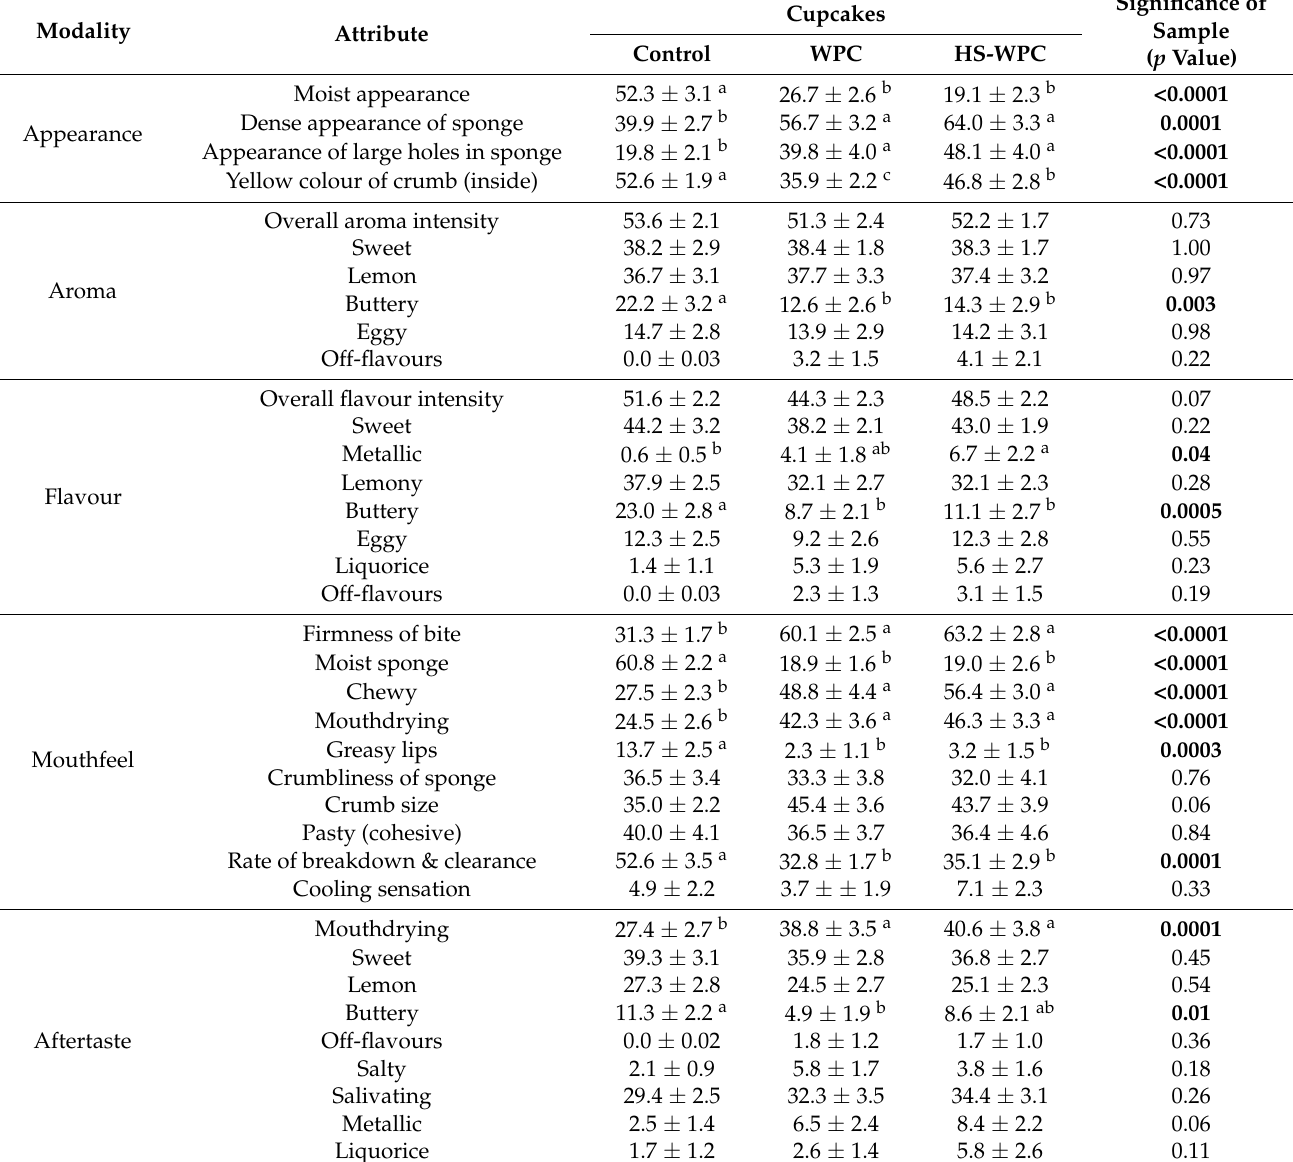
Significance of Cupcakes